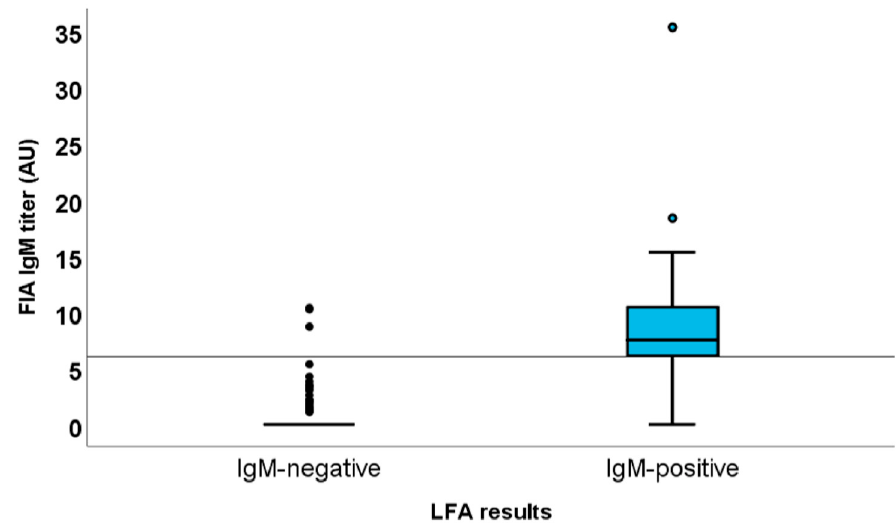
Figure 4. IgM titers lower than six by FIA were associated with IgM false-negative cases with LFA rapid tests.